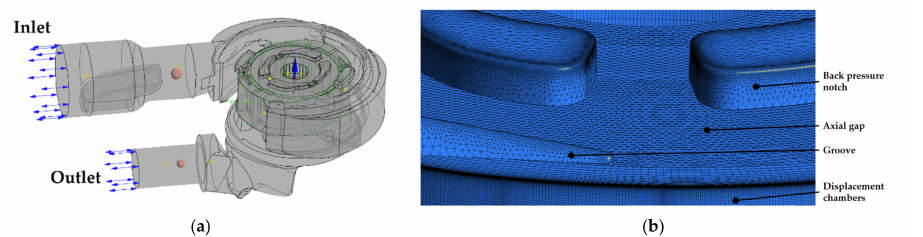
Figure 5. Full CFD model with BCs ( a ) and meshing details of the axial gaps and grooves ( b ) of the